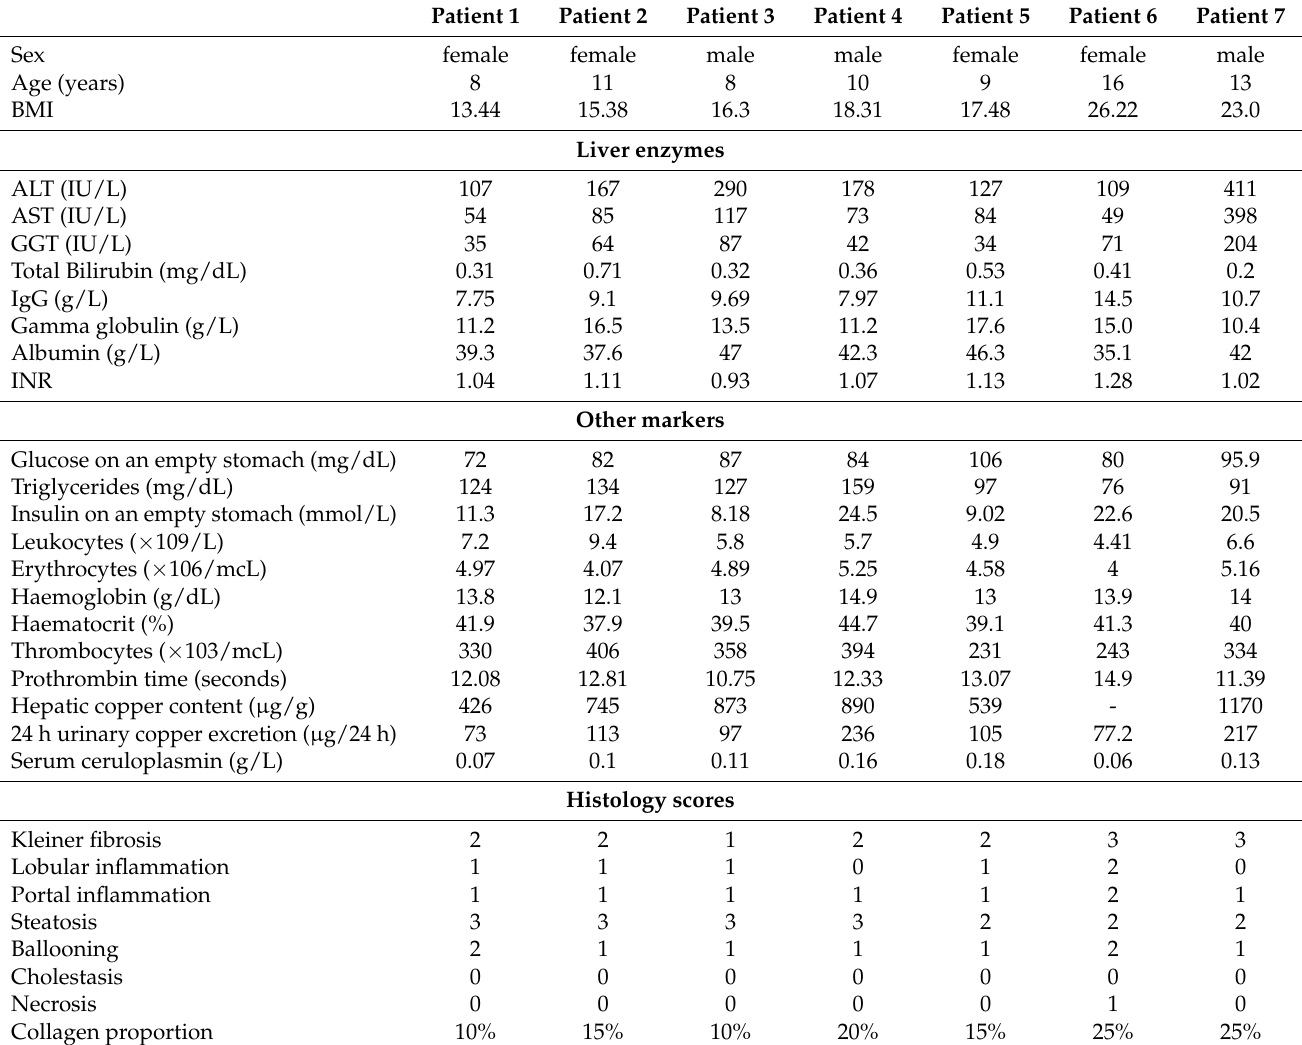
Table 1. Patient demographics and